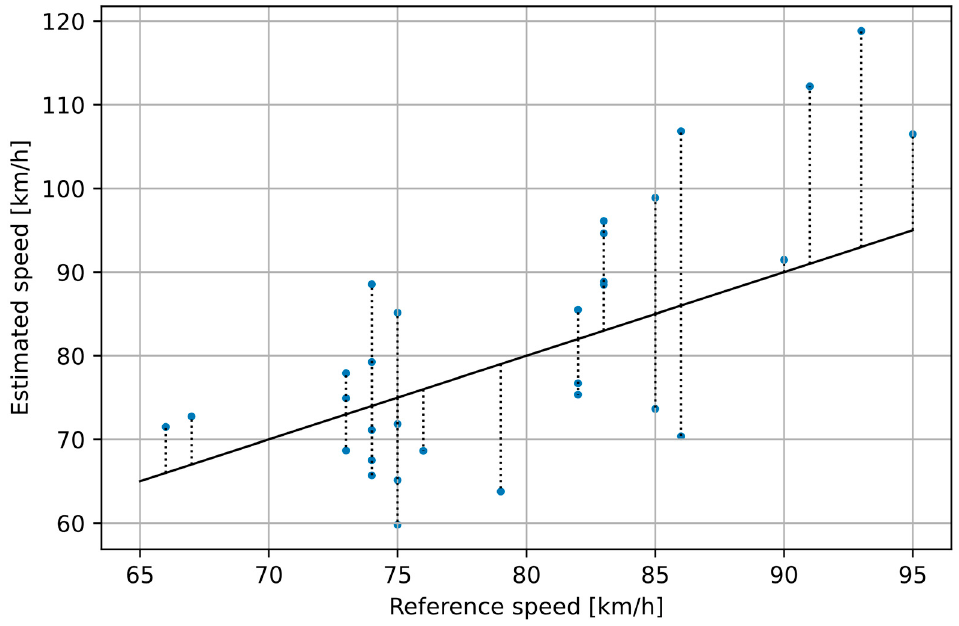
Figure 10. Estimated speed of individual vehicles vs. vehicle speed measured with the reference device.